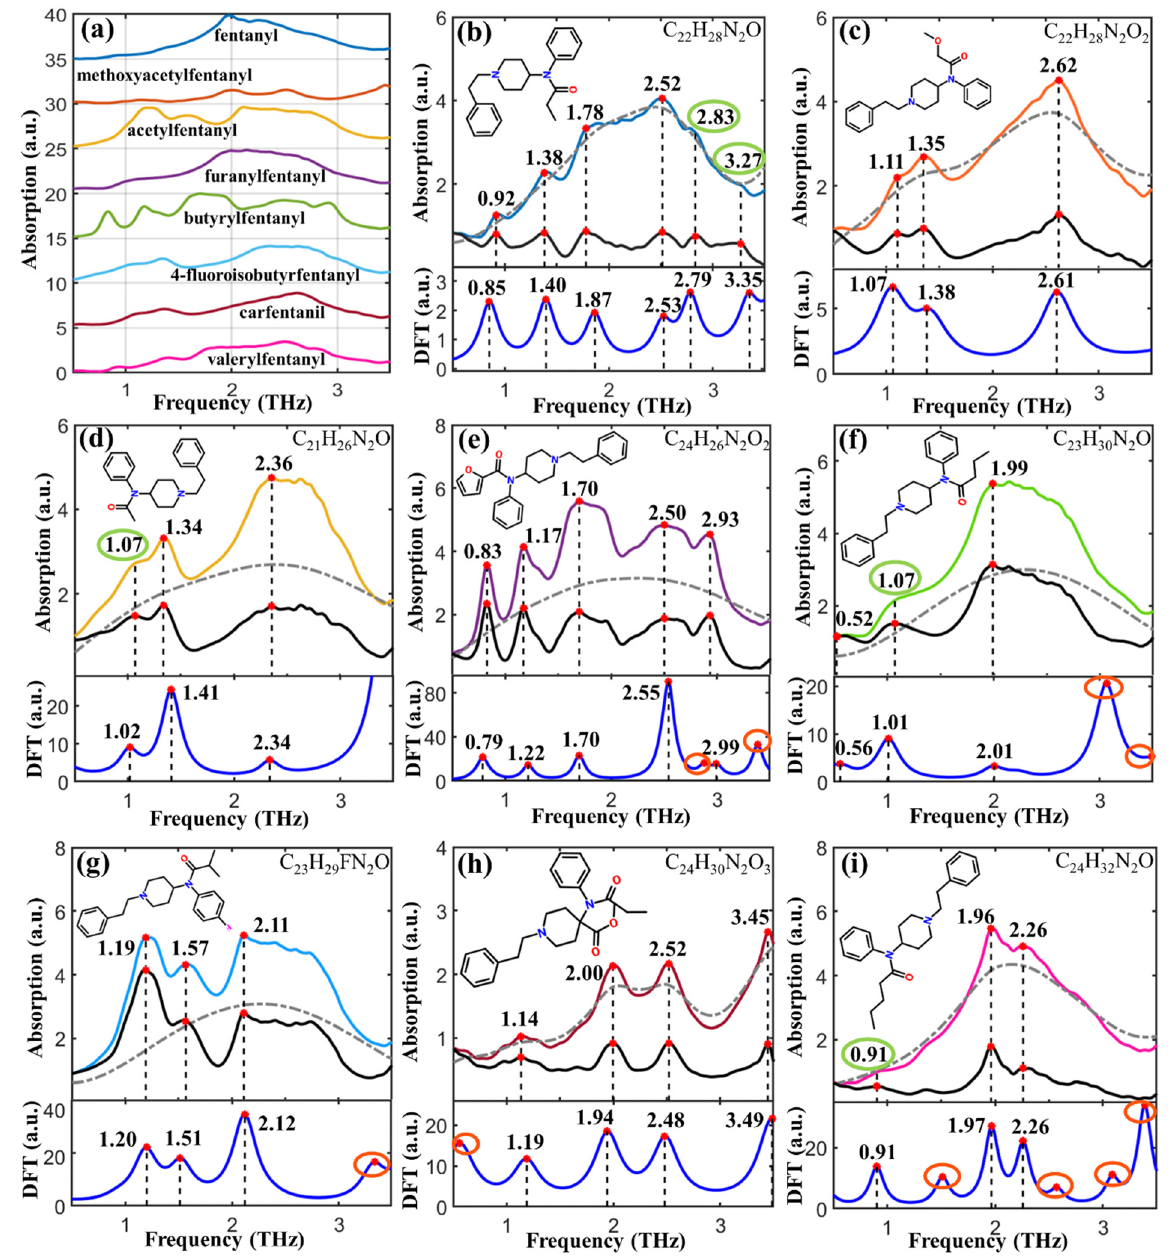
Figure 2. THz spectra of ( a ) eight fentanyl-related substances and spectral peak matching of ( b ) fentanyl, ( c ) methoxyacetylfentanyl, ( d ) acetylfentanyl, ( e ) furanylfentanyl, ( f ) butyrylfentanyl, ( g ) 4-fluoroisobutyrfentanyl, ( h ) carfentanil, and ( i ) valerylfentanyl.